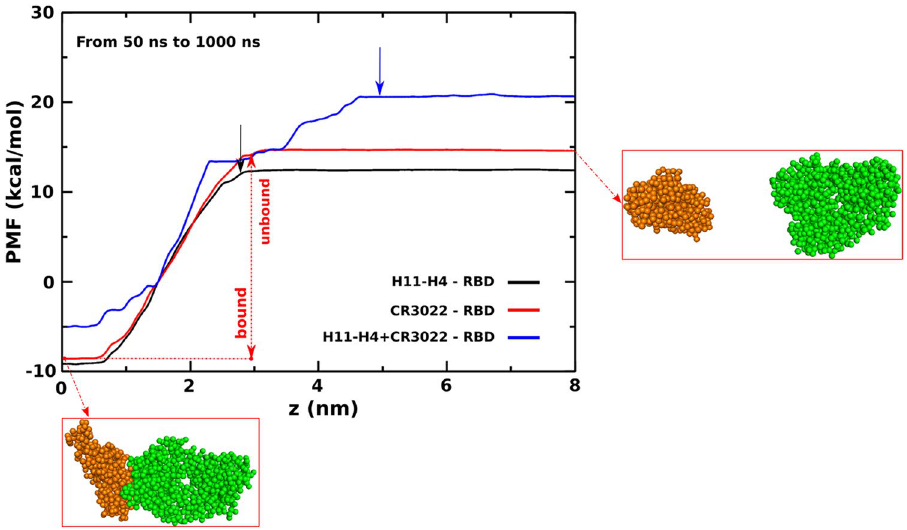
Figure 7. One-dimensional potential of mean force (1D PMF) of complexes H11-H4–RBD, CR3022–RBD and H11-H4 + CR3022-RBD as a function of the reaction coordinate. The result was obtained for a [50, 1000 ns] time window using CG-US simulations with the MARTINI force field. The left and right snapshots refer to the bound and unbound state of CR3022–RBD. The arrow indicates the position of the cutoff distance between bound and unbound